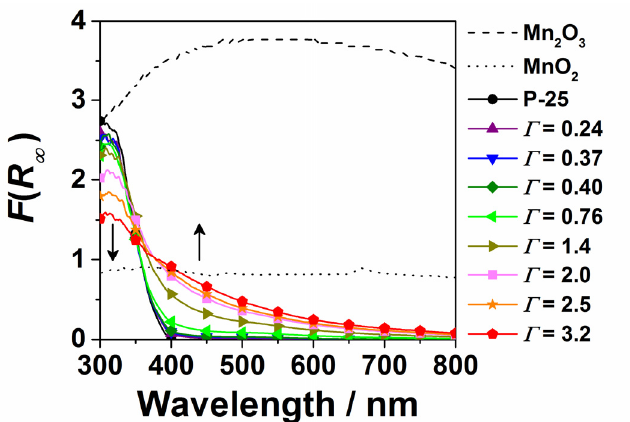
Figure 3. UV-visible absorption spectra of MnO amounts ( Γ /ions nm − 2 ).